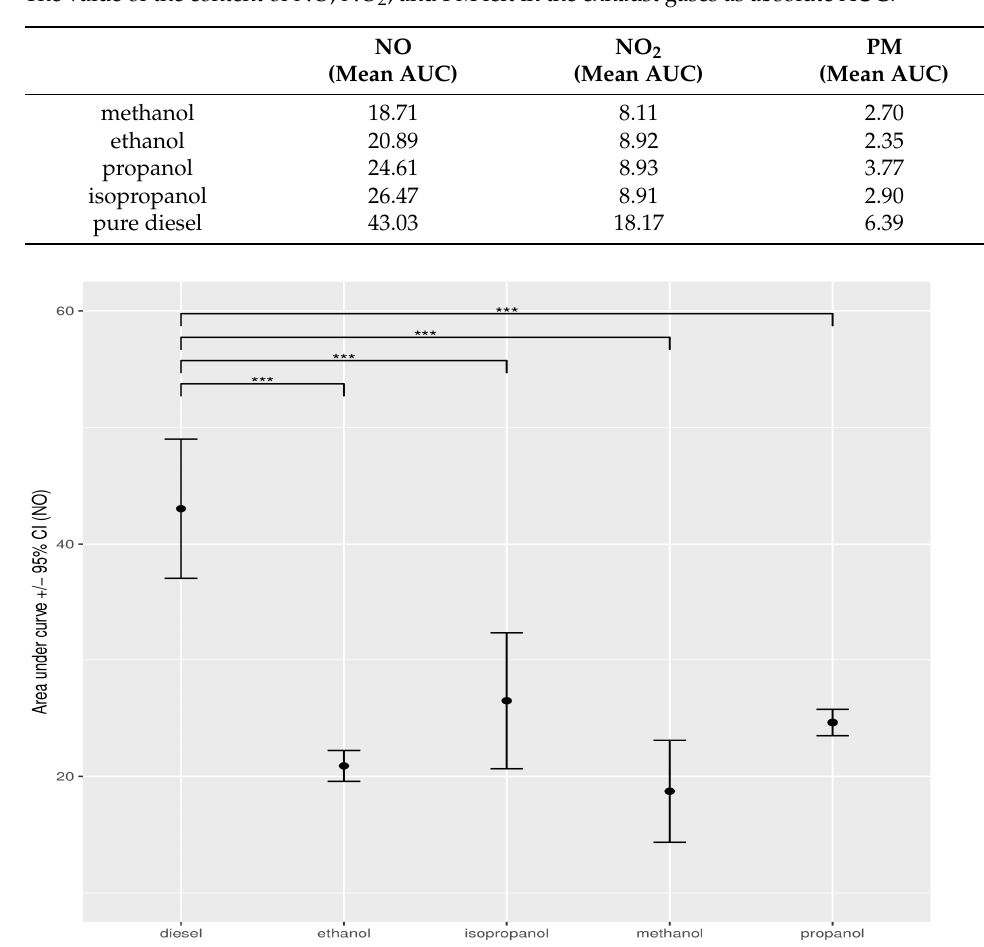
Table 3. Results of the statistical analysis of adding 2000 ppm of methanol, ethanol, and isopropanol. The value of the content of NO, NO 2 , and PM left in the exhaust gases as absolute AUC.